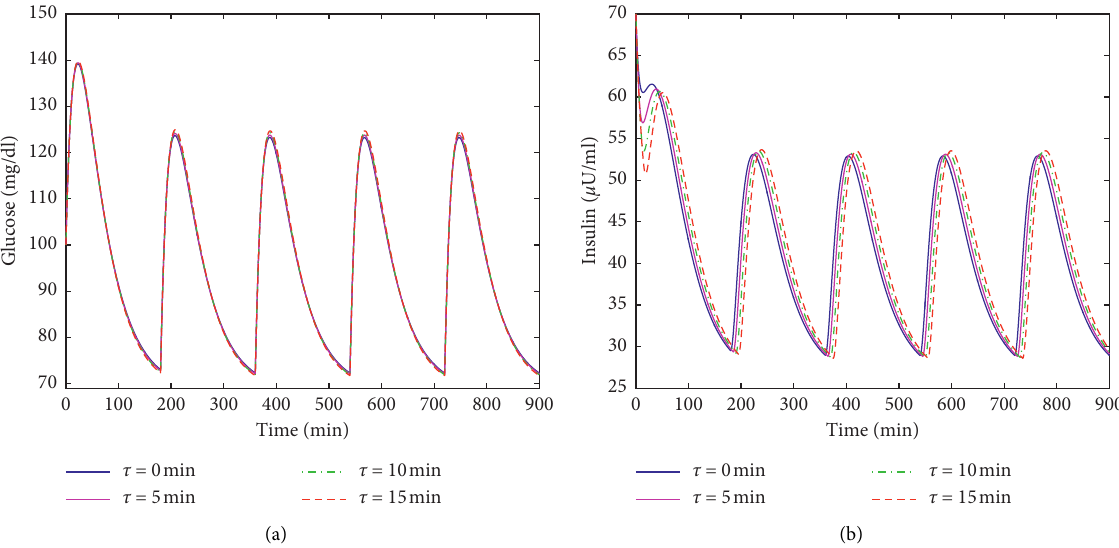
Figure 9: Effects of insulin secretion delay on system (5): (a) effects of insulin secretion delay on glucose level and (b) effects of insulin secretion delay on insulin